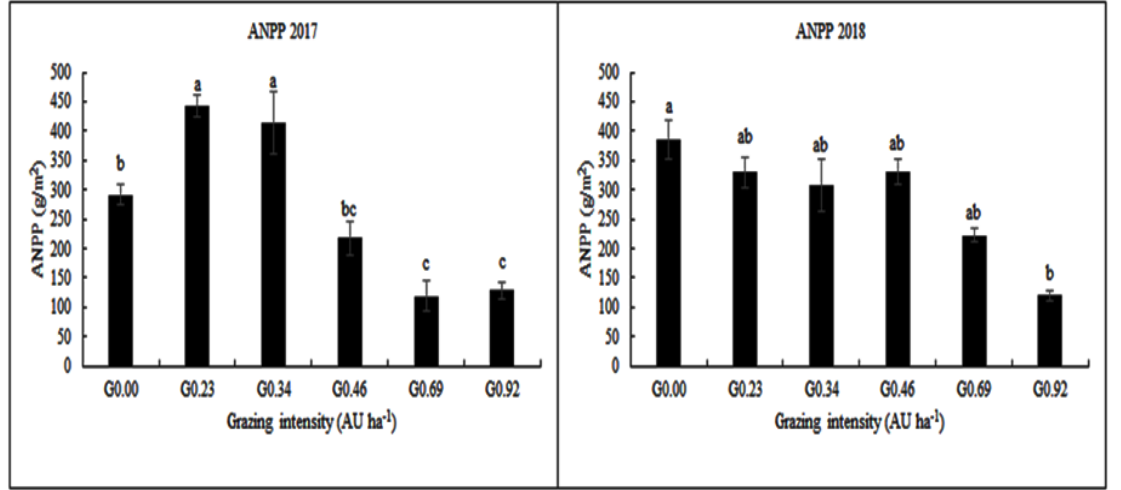
Figure 3. The effect of grazing intensity and season on aboveground biomass (AGB).